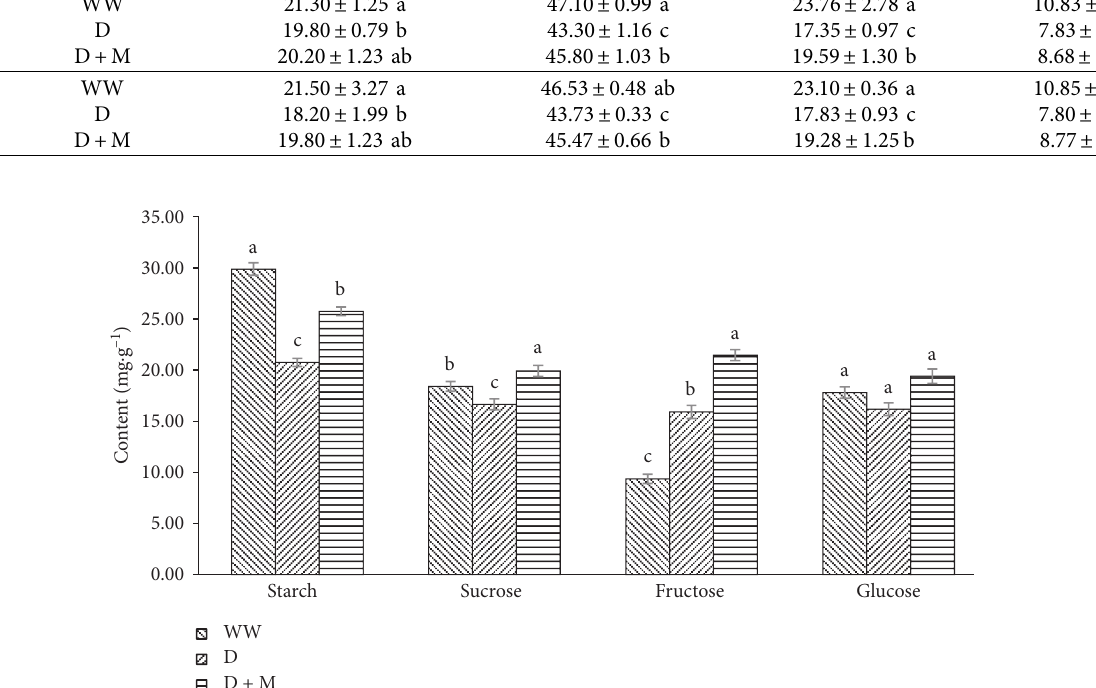
Figure 1: Effect of melatonin on carbohydrate contents in soybean under drought stress. Data are represented as average ± SD ( n � 3). Different letters indicate significant differences ( p < 0 . 05).